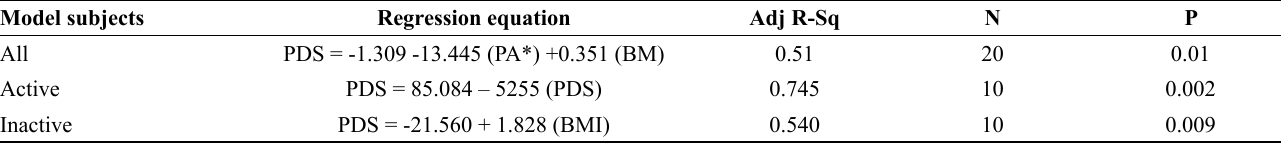
Table 2. Influence of the physical activity level in the prediction of the percentage decrement score (PDS). Model